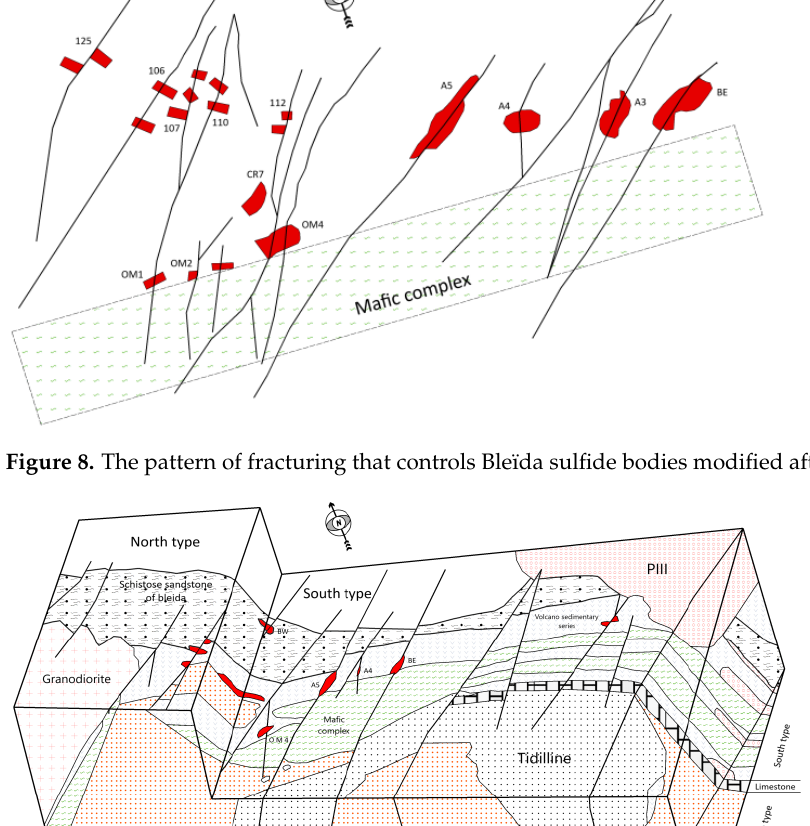
Figure 8. The pattern of fracturing that controls Bleïda sulfide bodies modified after [53].